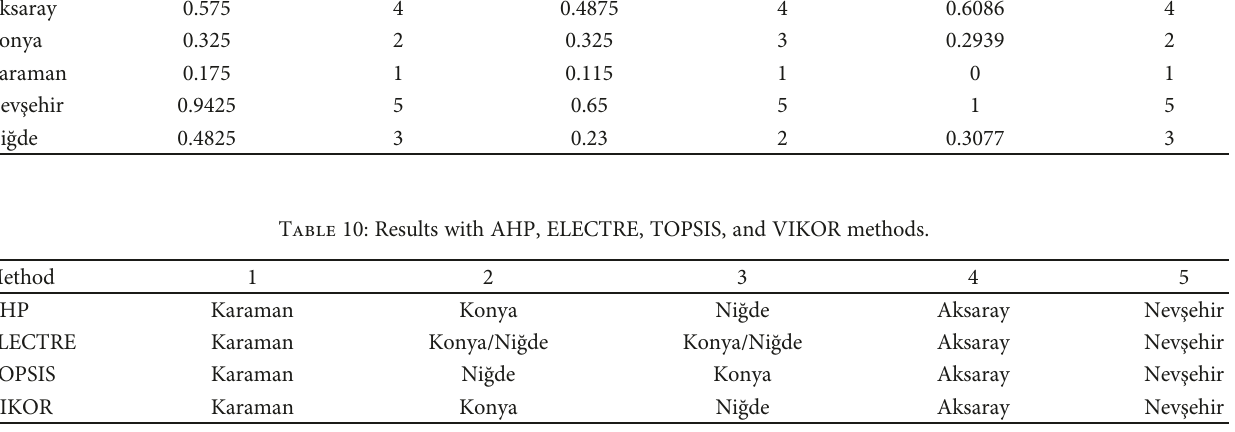
Table 9: Values of S